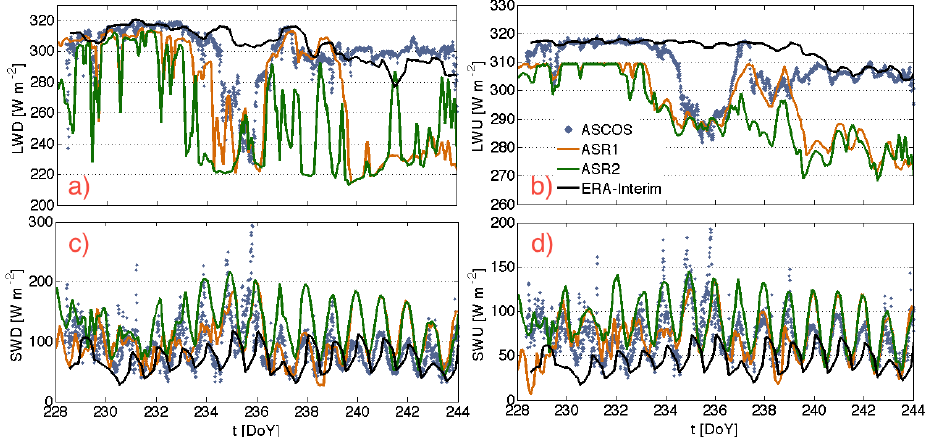
Fig. 12. Time series of the surface radiation components from the ASCOS ice drift showing (a) downward longwave (LWD), (b) upward longwave (LWU), (c) downward shortwave (SWD) and (d) upward shortwave radiation (SWU), all in Wm − 2 , as a function of the time in day of year (DoY)